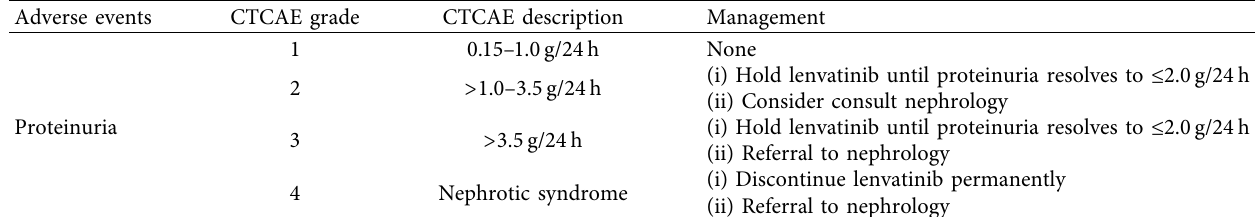
Figure 2: Chest X-rays revealing moderate amount of right pleural effusion with pressure effect caused trachea shift to the left (a) and complete resolution of right pleural effusion after discontinuing lenvatinib for 1 week (b). Table 1: Common adverse events and recommended management for lenvatinib